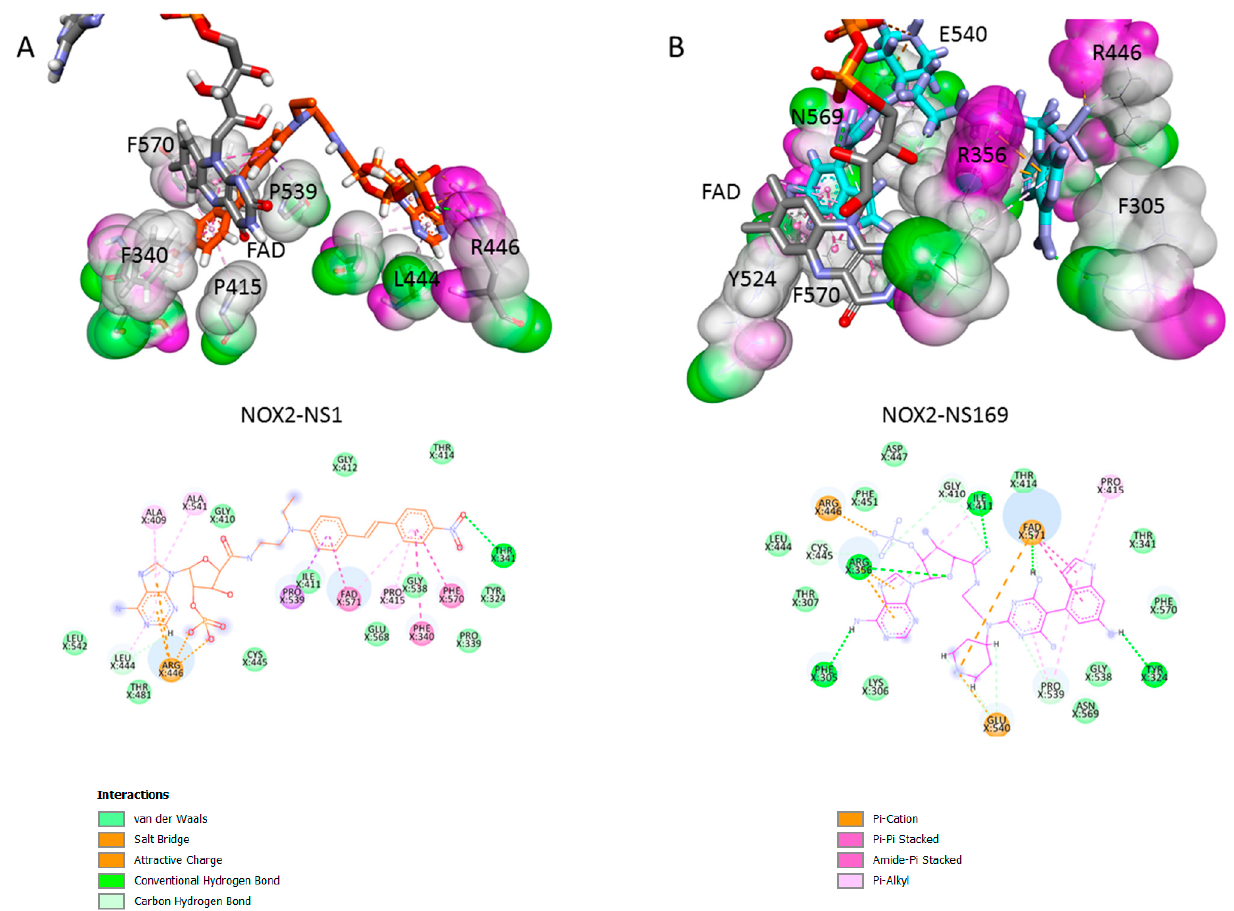
Figure 7. Comparison of the interactions of NS1 (A) shown in orange and NS169 (B) shown in blue with NOX2: FAD isoalloxazine is shown in grey sticks, its pyrophosphate groups in yellow (P) and red (O), the van der Waals surface is shown as H-bond donor or acceptor in violet and in green. Below are the 2D interaction maps between the inhibitors and interacting residues of NOX2, each residue being depicted according to the following color codes.